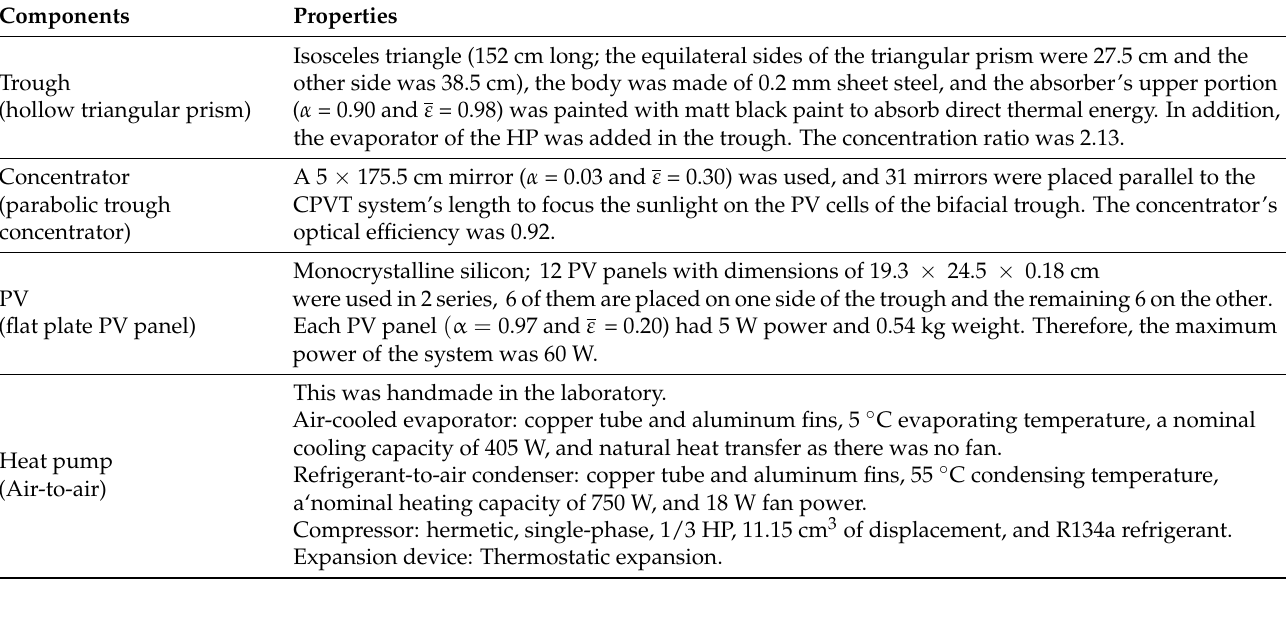
Table 1. Technical properties of the bifacial CPVT system with HP.